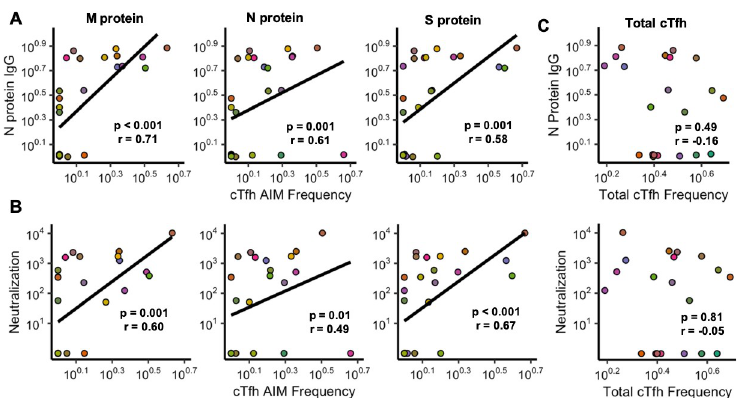
Fig 3. SARS-CoV-2-specific cTfh frequencies across the M, N, and S proteins correlate with antibody neutralization (N = 26). (A) Correlations between N protein IgG titers and cTfh frequencies towards the M, N, and S proteins. (B) Correlations between antibody neutralization (ID50, dilution of plasma at which luminescence was reduced to 50%) and cTfh frequencies. (C) Correlations between the total cTfh frequency and antibody titer and neutralization. (All correlations represented by a linear regression line. Axes are transformed by log10(x+1) to allow for visualization of 0s. Statistics were determined by a Spearman Correlation test. Points are colored for each